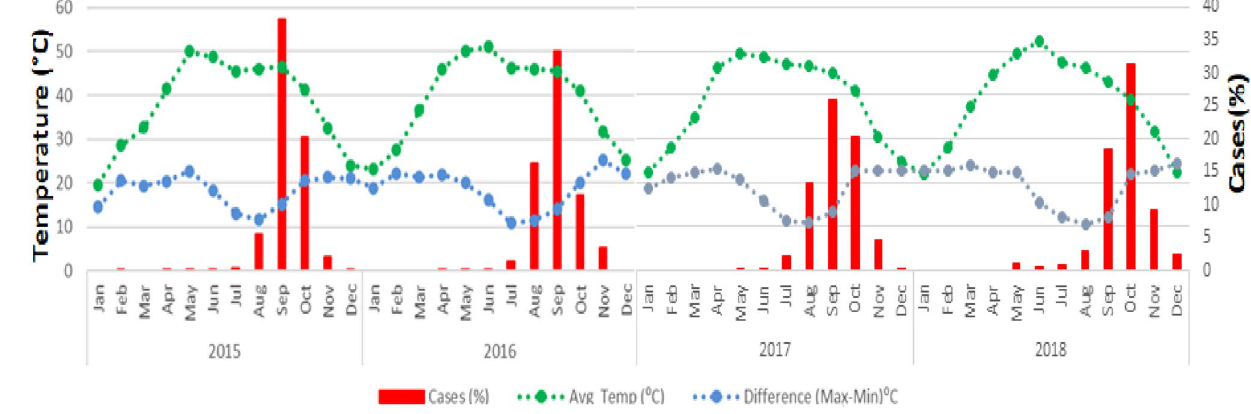
Figure 5. Monthly occurrences of dengue fever and average temperature and difference between the maximum and minimum average monthly temperature, 2015–18, Delhi.